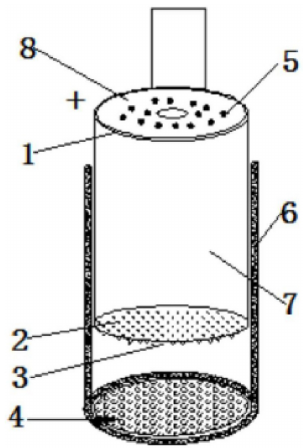
Figure 24. Schematic diagram of a high-power cell with 1: positive current collector plate, 2: Cu mesh, 3: burr, 4: Ni foam, 5: welding spot, 6: insulator, 7: cell, and 8: positive terminal [309].